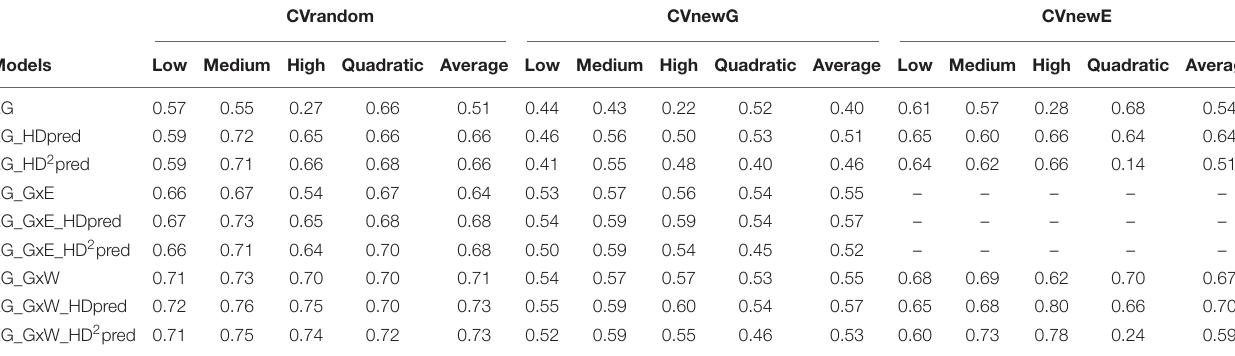
TABLE 4 | Predictive abilities of the reference and of the CGM-TAP models in three prediction scenarios with HD as the secondary trait and GY as the target trait. CVrandom CVnewG CVnewE